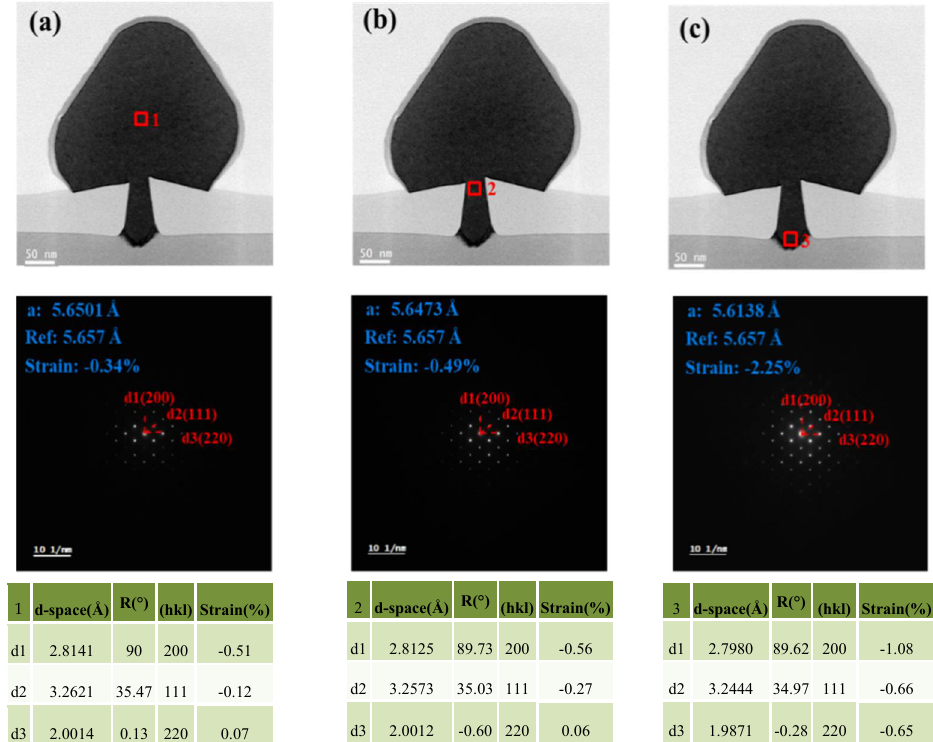
Figure 10. Cross − section HRTEM images of the Ge epi-layer: ( a ) above the fin head, ( b ) located in the middle (around the fin top) and ( c ) bottom part of the channel. The electron diffraction patterns of different regions are presented in each group.